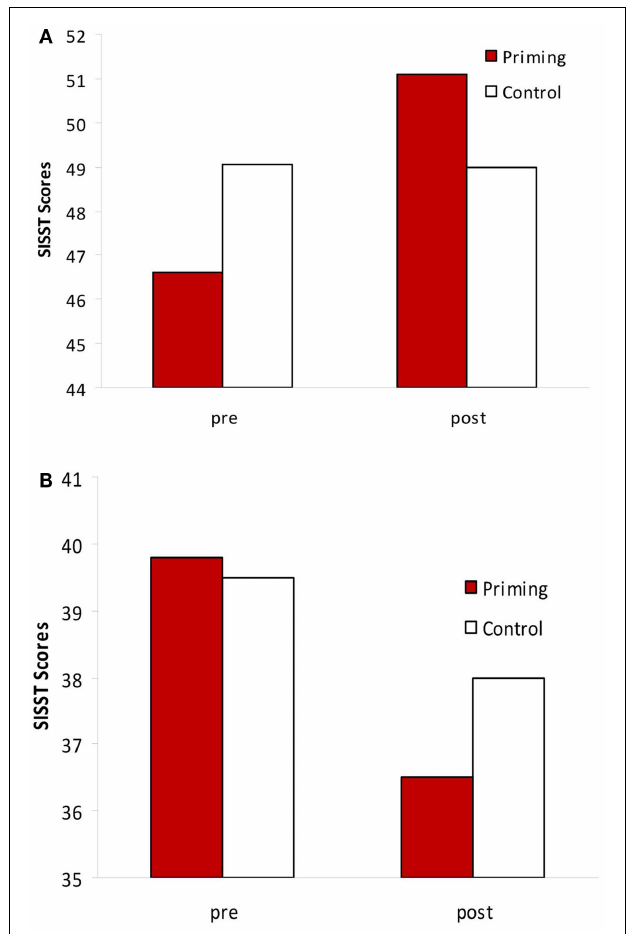
FIGURE 1 | (A) SISST-positive statements changes before and after the priming vs. the control procedure. Priming: t = 3.1, p = 0.006; control: t = 0.86, ns. (B) SISST-negative statements changes before and after the priming vs. the control procedure. Priming: t = 2.18, p = 0.04; control: t = 1.1,